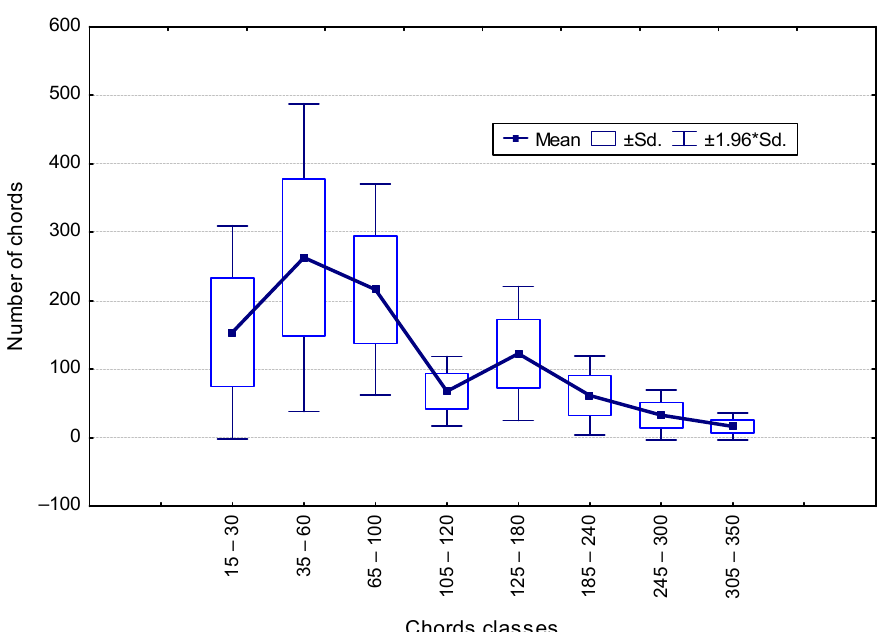
Figure 4. Distribution of chords for eight classes.